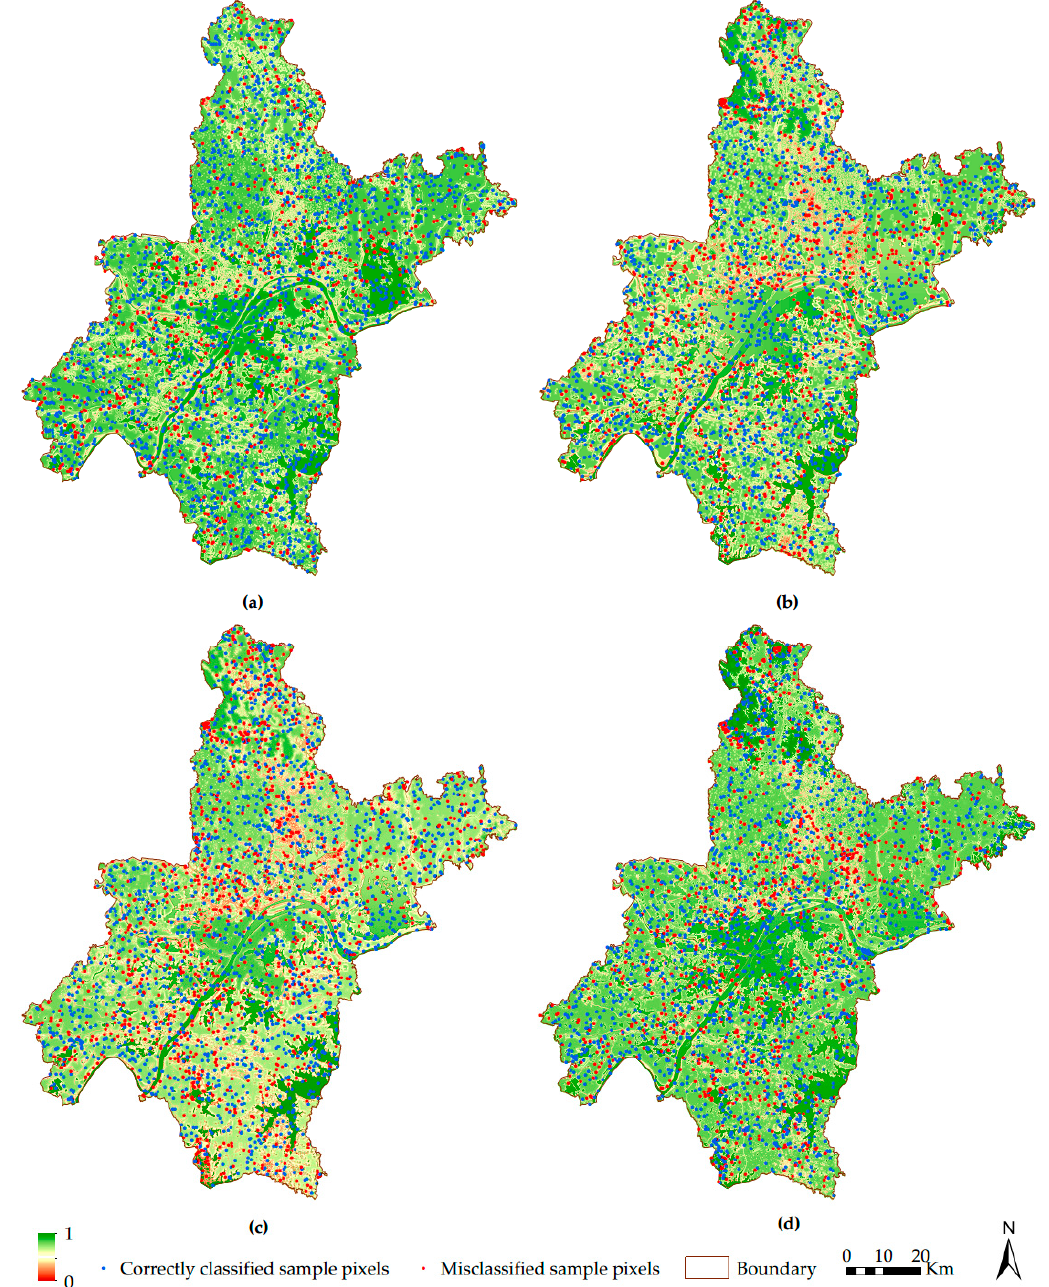
Figure 2. Maps of per-pixel probabilities of correct classification estimated by different methods (overlaid with observed classification correctness indicators at respective model-training sample pixels): ( a ) CA, ( b ) CS, ( c ) EI, and ( d ) EO.